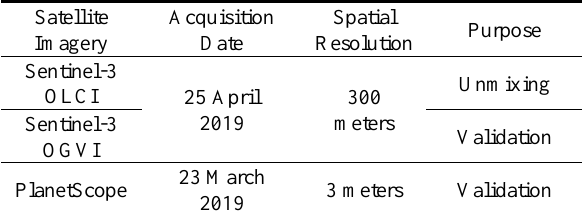
Table 1. Summary of satellite images used in this study